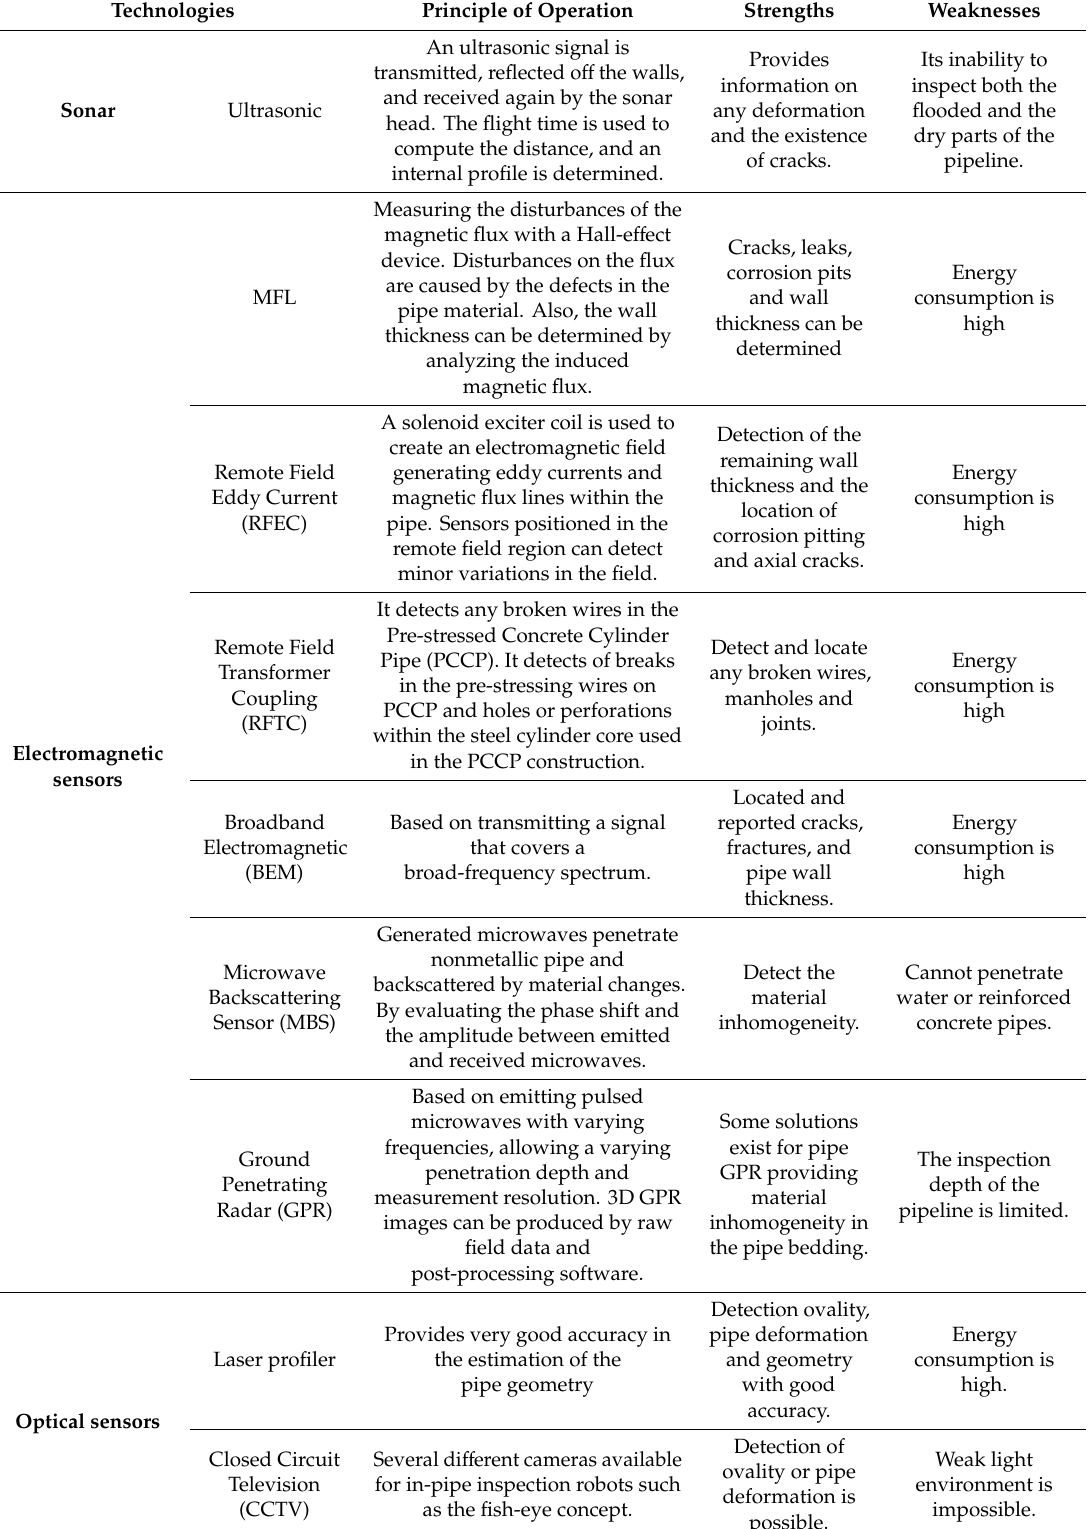
Table 2. Summary of interior pipeline leakage detection